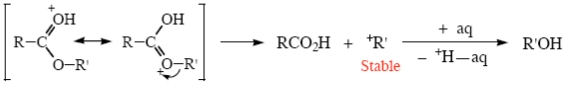
Acid hydrolysis of esters capable of forming carbocations.